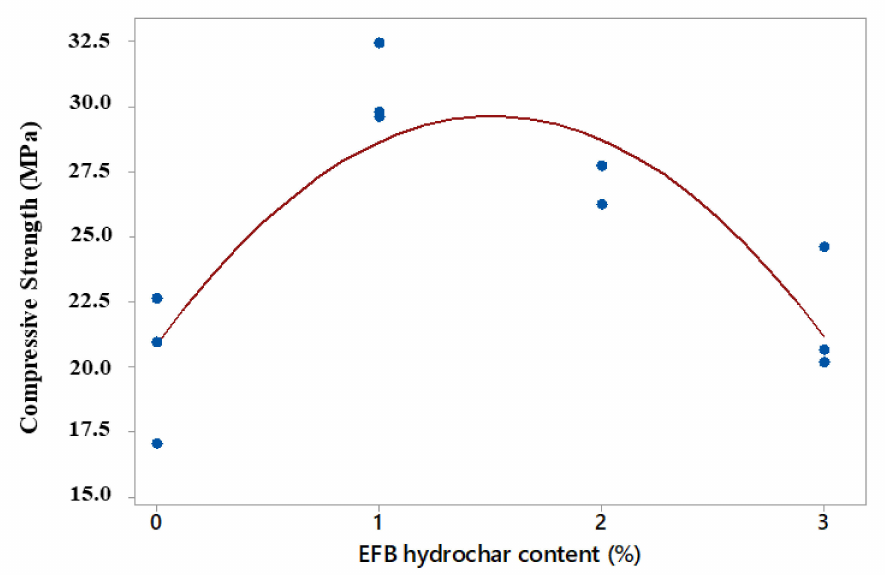
Figure 9. The quadratic model of the relationship between the compressive strength of the mortar and hydrochar